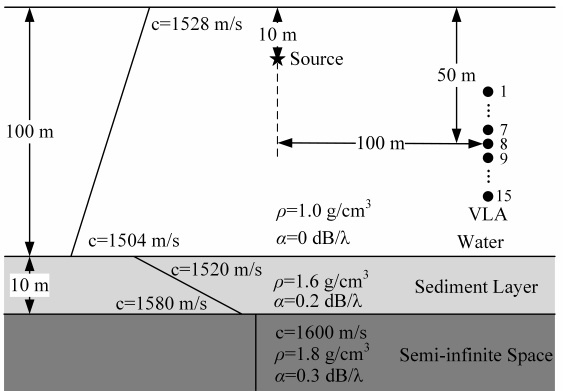
Figure 1. The sketch of the shallow water environment and the arrangement of the source and the